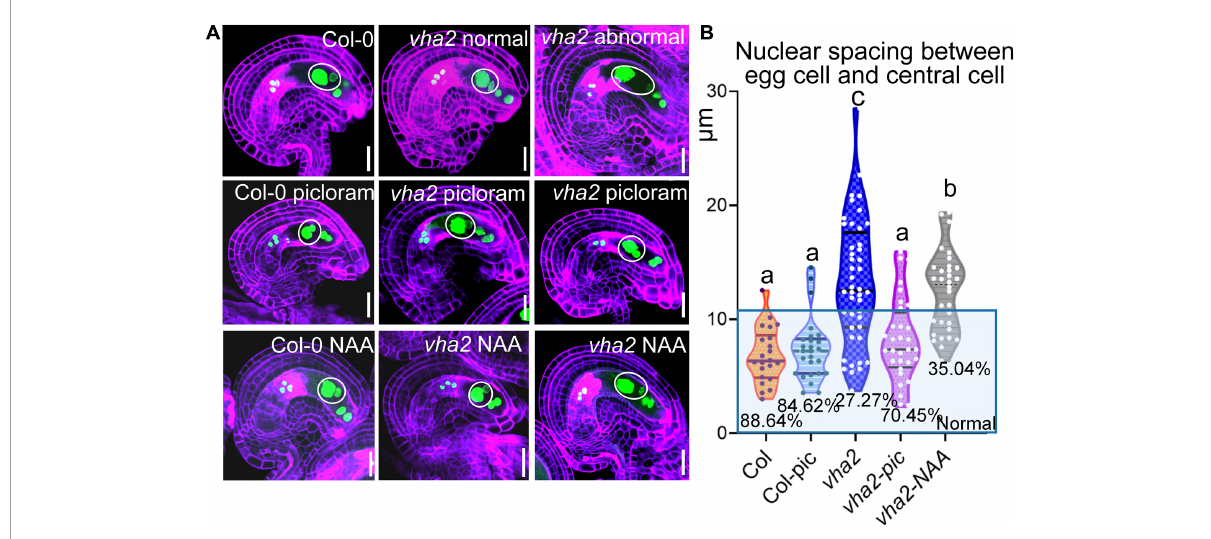
FIGURE7 Picloram rescues the enlarged nuclear spacing of egg cells and central cells in vha2 through PIN-independent pathway. (A) Nuclear spacing of Col-0 and vha2 under picloram and NAA treatment at FG6 stage visualized using ProES1:H2B-GFP (green) by fluorescence microscopy. Cell walls were stained with FB28 (purple). Inflorescence apices grew for 2 days following 1 µ M picloram or 1 µ M NAA treatment for 24 h. In the white circles are nuclear of egg cells and central cells. Graphs represent the typical phenotype of all samples. Bars = 20 µ m. (B) Statistics analysis of nuclear spacing between egg cell and central cell in Col and vha2. Dots in the blue box represent normal samples with nuclear spacing of egg cells and central cells less than 10 µ m, and the proportions are shown in the chart. Lowercase letters indicate statistically significant differences between different stages ( P < 0.05). 40 ovules shown in the statistical graph come from 10 different inflorescence apices.